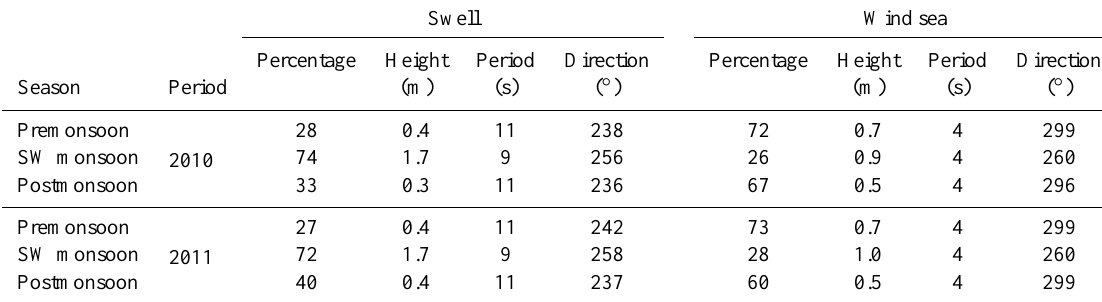
Table 2. Classification of sea state based on inverse wave age calculated using U 10 / C p and U 10 cos θ / C p . classification based on U 10 / C p classification based on U 10 cos θ / C p Wind Mixed Wave driven/ Wind Mixed Wave driven/ driven wave modified wind driven